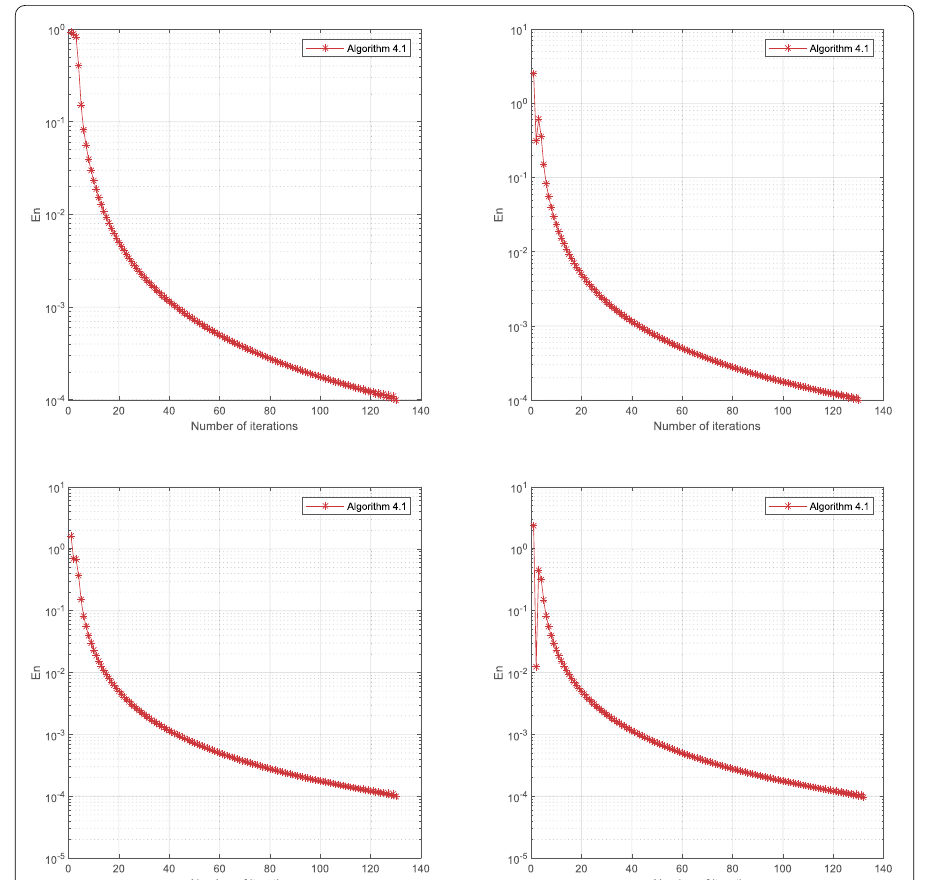
Figure 2 Example 6.2, Top left: Case I; Top right: Case II; Bottom left: Case III; Bottom right: Case